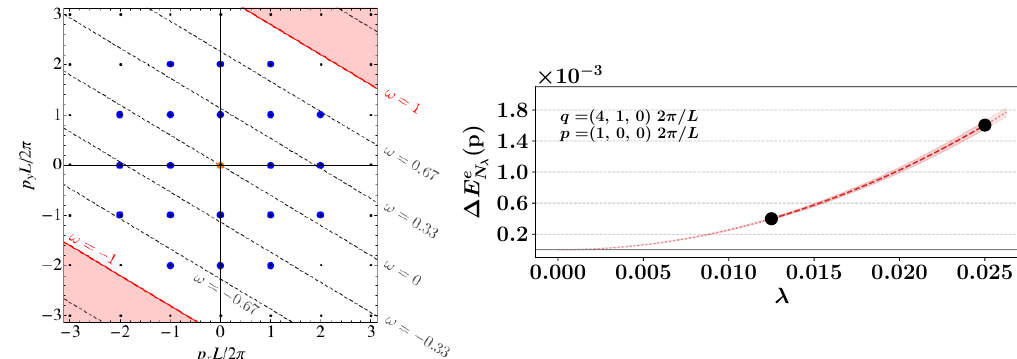
Fig 3. As an example consider fixed (cid:126) q = ( 2 π/ L )( 3,5,0 ) . We can access different ω by varying